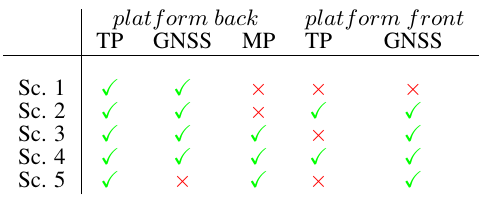
Table 1. Combination of observations used for the different scenarios ( (cid:88) = used, × = not used). TP: image coordinates of tie points, GNSS: position of GNSS antenna, MP: image coordinates of marker points placed on platform front . and observed by platform